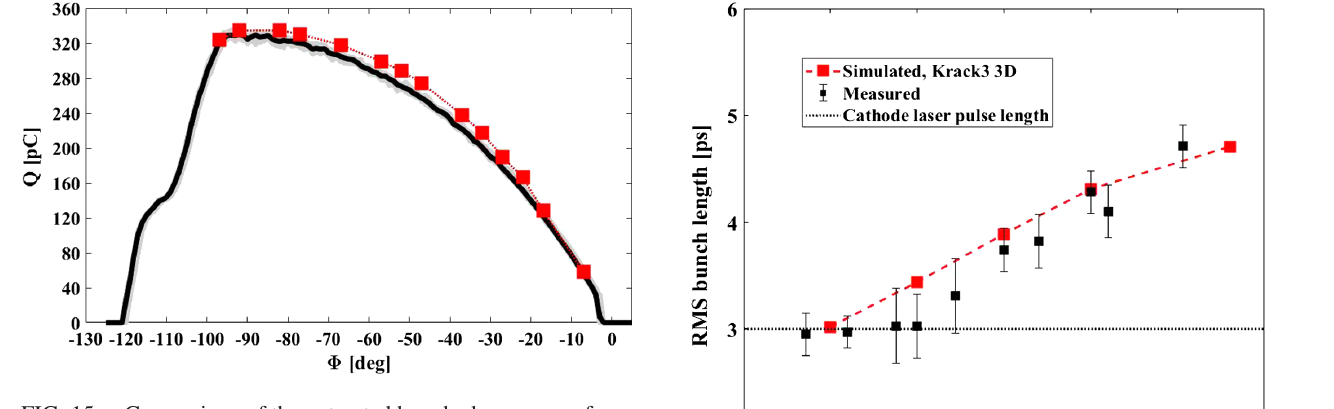
FIG. 15. Comparison of the extracted bunch charge over rf gun phases between measurement and simulation. Red curve with markers: simulation; Black curve: measurement.